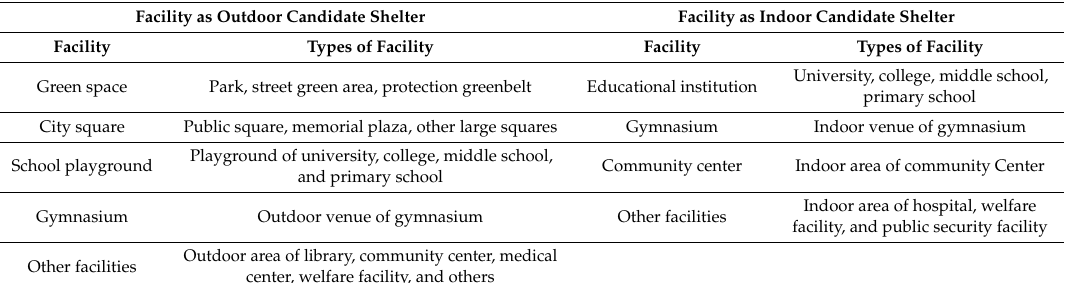
Table 2. Resource types considered as candidate